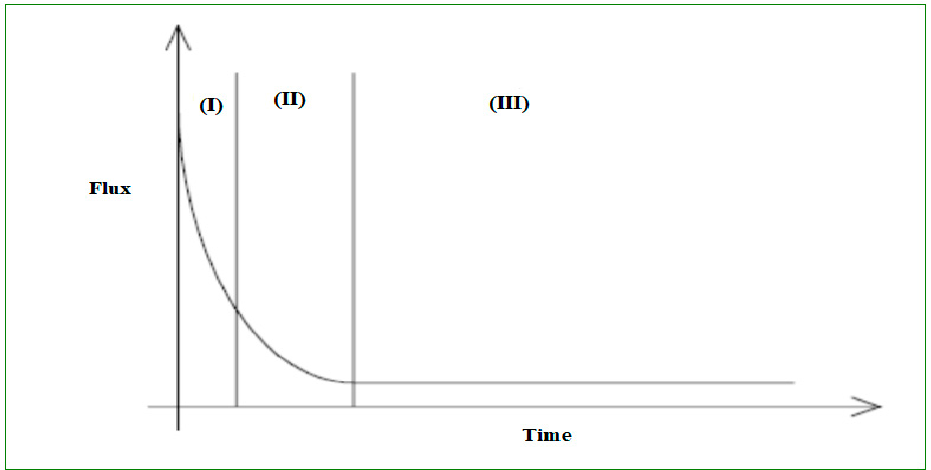
Figure 5. A Schematic representation of the stages in flux decline [218].